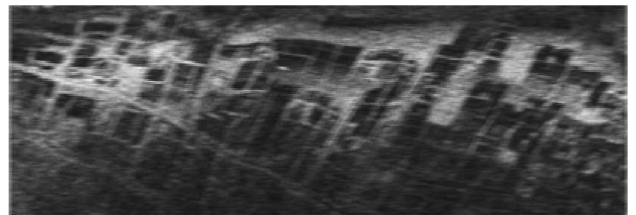
Figure 15. Real data processing results by traditional NLCS